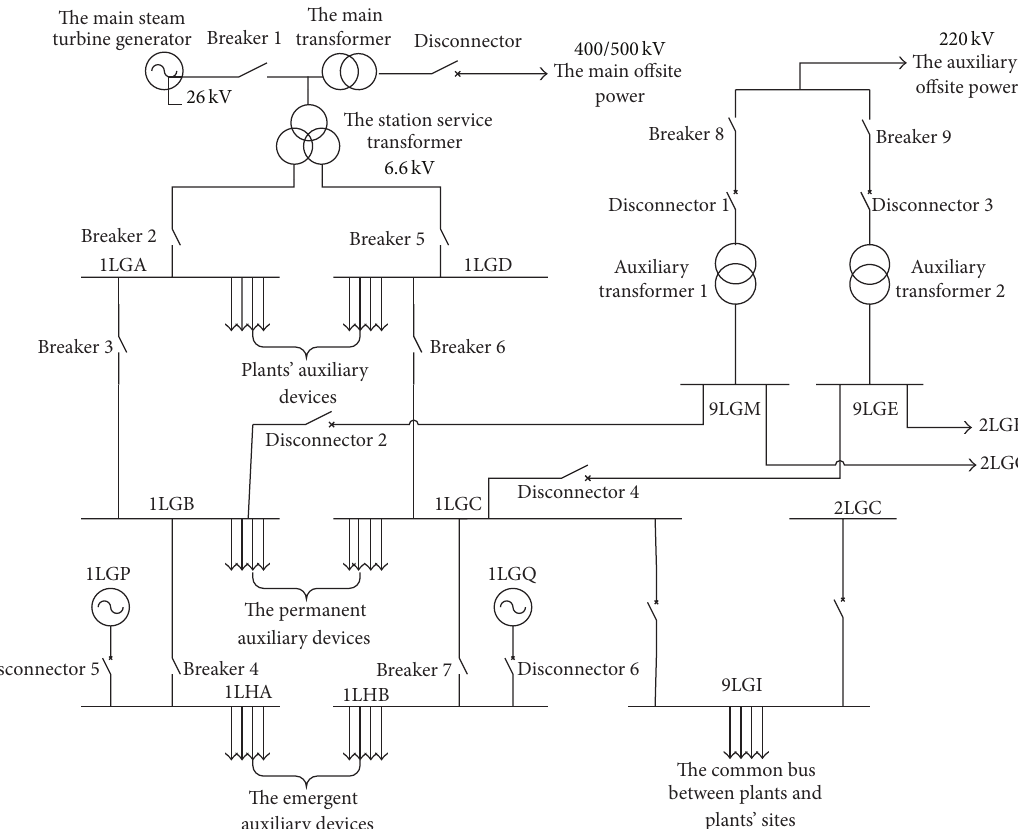
Figure 5: Diagram of NPP’s power supply